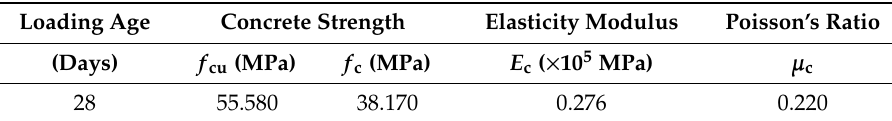
Table 2. Concrete mechanical properties.